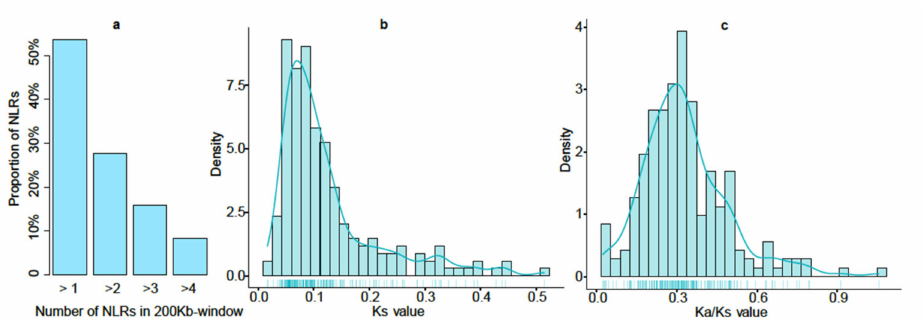
Figure 2. The distribution of NLRs in 200 Kb windows and the calculation of Ka (number of substitutions per nonsynonymous site) and Ks (number of substitutions per synonymous site) values of paired NLRs. ( a ) The proportion of NLR proteins distributed on each 200 Kb slide window as gene clusters; the distribution of Ks values ( b ) and Ka/Ks ratio ( c ) of paired